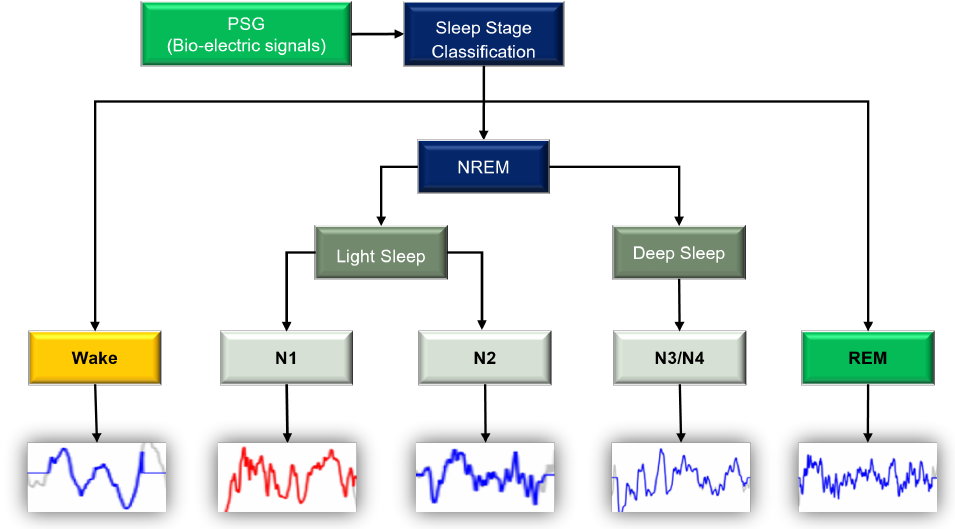
Figure 1. Schematic diagram of the sleep stages according to EEG signals. The annotation was created according to RK standards and AASM recommendations for classifying sleep